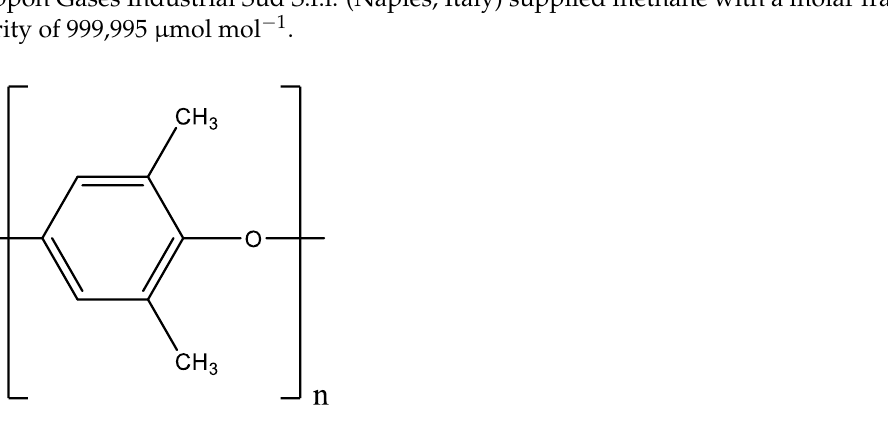
Figure 1. Repeating unit of Poly(2,6-dimethyl-1,4-phenylene)oxide.